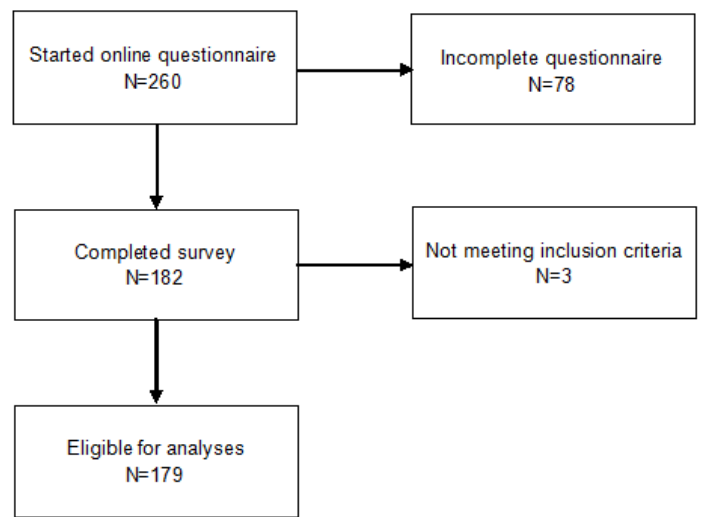
Figure 1. Data selection process for